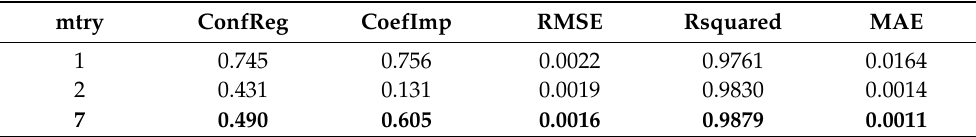
Table 7. Regularized random forest.